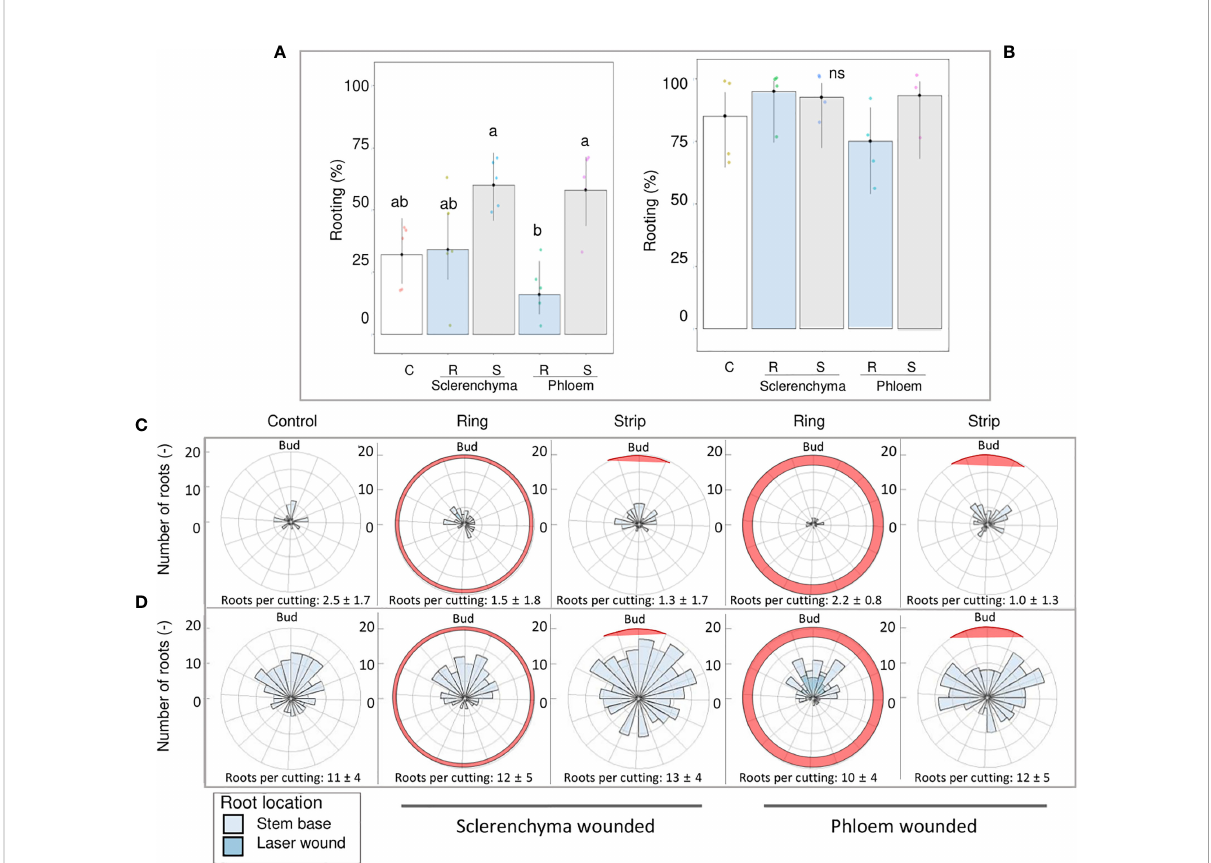
FIGURE 8 Comparison of ring and strip pattern laser treatments reaching de fi ned tissue layers regarding rooting percentage and root distribution. AR formation of R. canina ‘ Pfänder ’ (A) and Rosa ‘ Tan09283 ’ (B) cuttings when phloem and sclerenchyma layer were wounded without exogenous auxin. C- control treatment, R- ring pattern, S- strip pattern. Columns represent mean values and con fi dence intervals (n= 50 for R. canina ‘ Pfänder ’ R02-6 and n= 40 Rosa ‘ Tan09283 ’ ). Root spatial distribution of the treatments for R. canina ‘ Pfänder ’ R02-6 (C) and Rosa ‘ Tan09283 ’ (D) . Red shaded region represents the laser treatment position in relation to the axillary bud. Columns that do not share a common letter represent signi fi cantly different levels (Tukey test, p ≤ 0.05); ns, non-signi fi